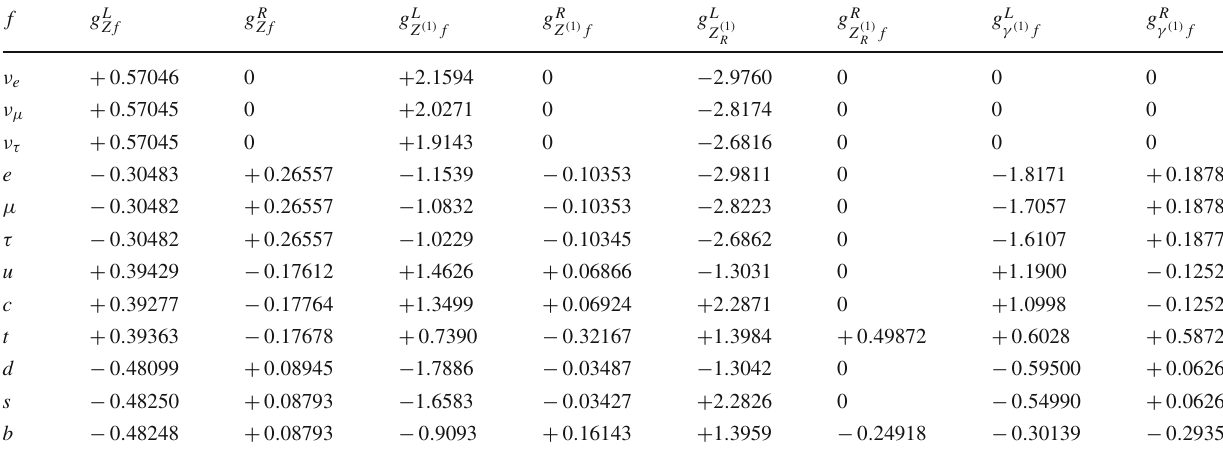
Table 8 Z (cid:3) couplings of fermions for θ H = 0 . 08, c l , c q < 0 The same unit as in Table 3